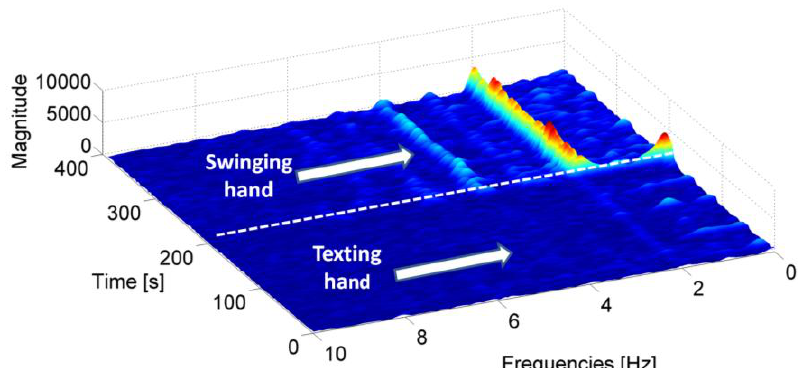
Figure 6. Spectrogram of the gyroscope signal for a walking user. The IMU is alternatively carried in the texting and swinging hand of the